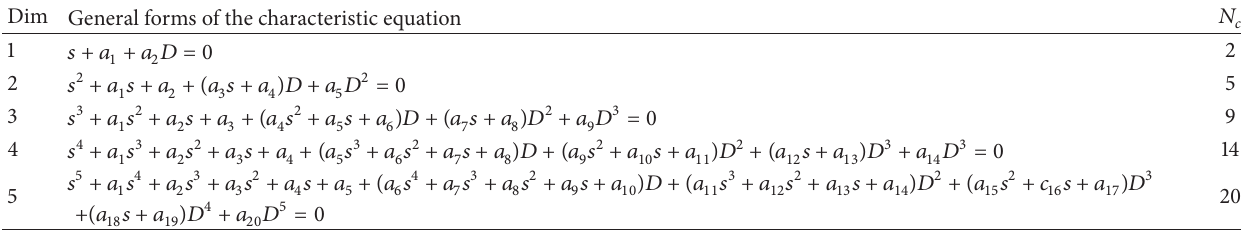
Table 1: General forms of the characteristic equation for time-delayed